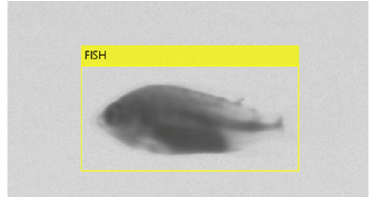
Figure 7. Fish detection by the algorithm.